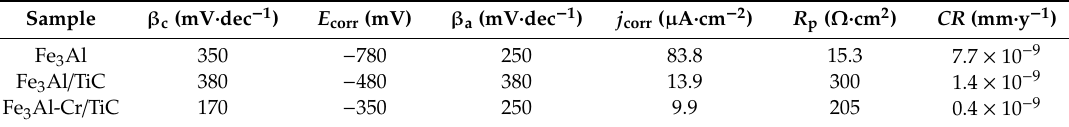
Table 3. Corrosion parameters obtained from the polarization curves.